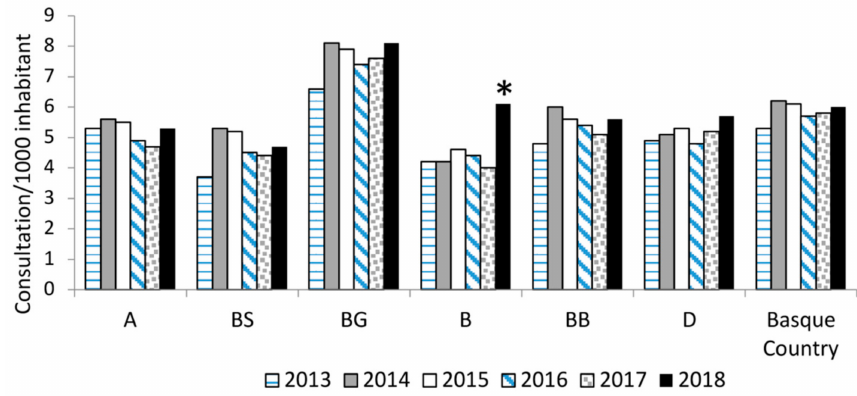
Figure 4. Insect bite consultations per 1000 inhabitants in the Health Counties where Ae. albopictus eggs were detected for the period 2013–2018 (A = Araba; BS = Barakaldo-Sestao; BG = Barrualde-Galdakao; B = Bidasoa; BB = Bilbao Basurto; D = Donostiadea). Significant increases are indicated by